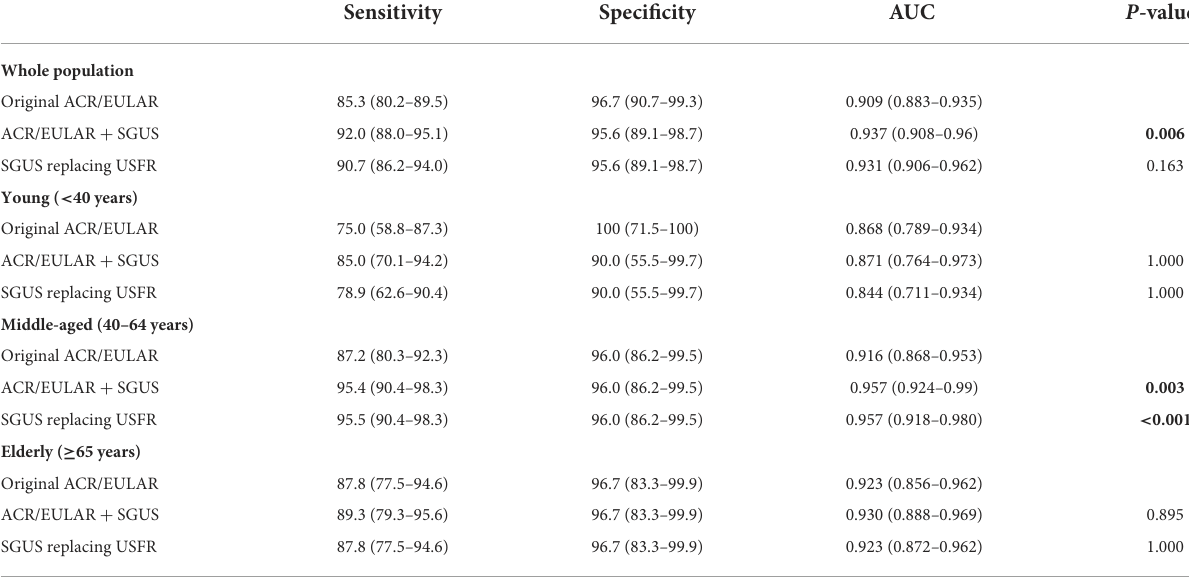
TABLE 4 Performance of the original and modified ACR/EULARcriteria incorporating SGUS and replacing USFR by SGUS according to the age